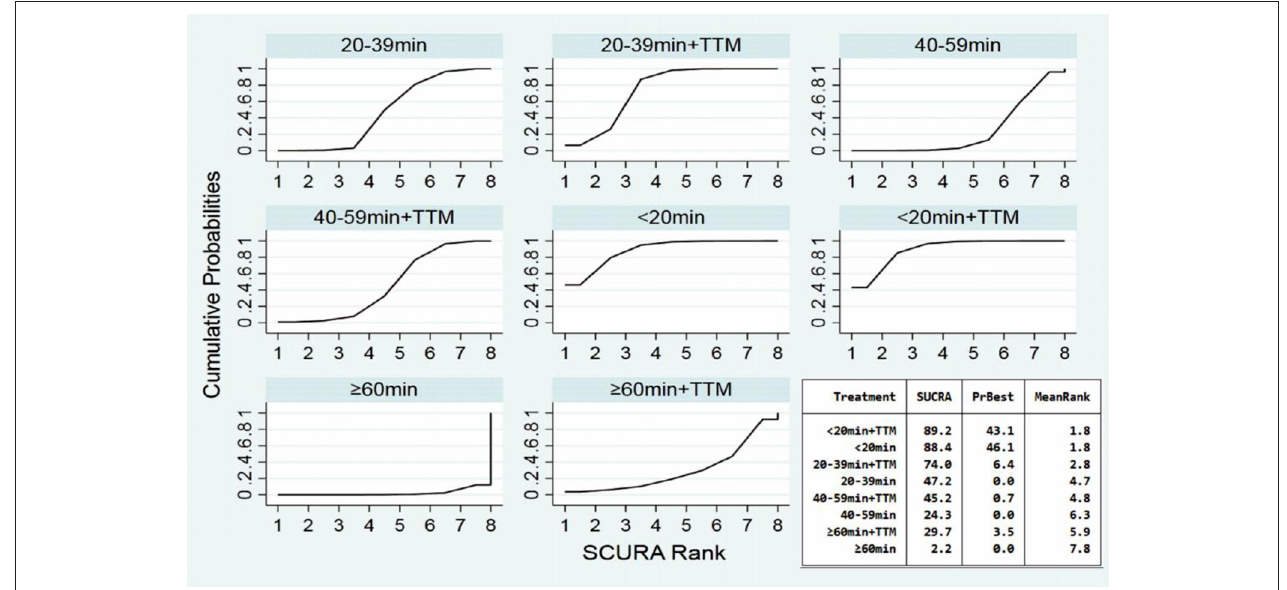
FIGURE 4 | SUCRA plot for survival (the area of SUCRA is shown in the lower right